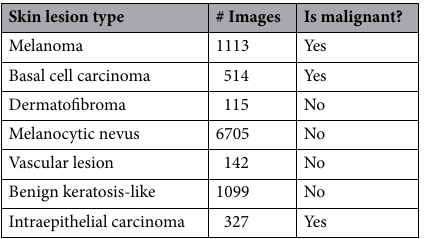
Table 1. Detailed information on classes for HAM10000